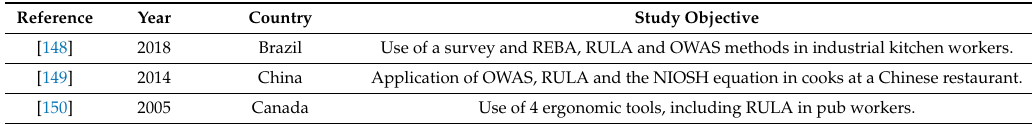
Table 10. Accommodation and food service activities.